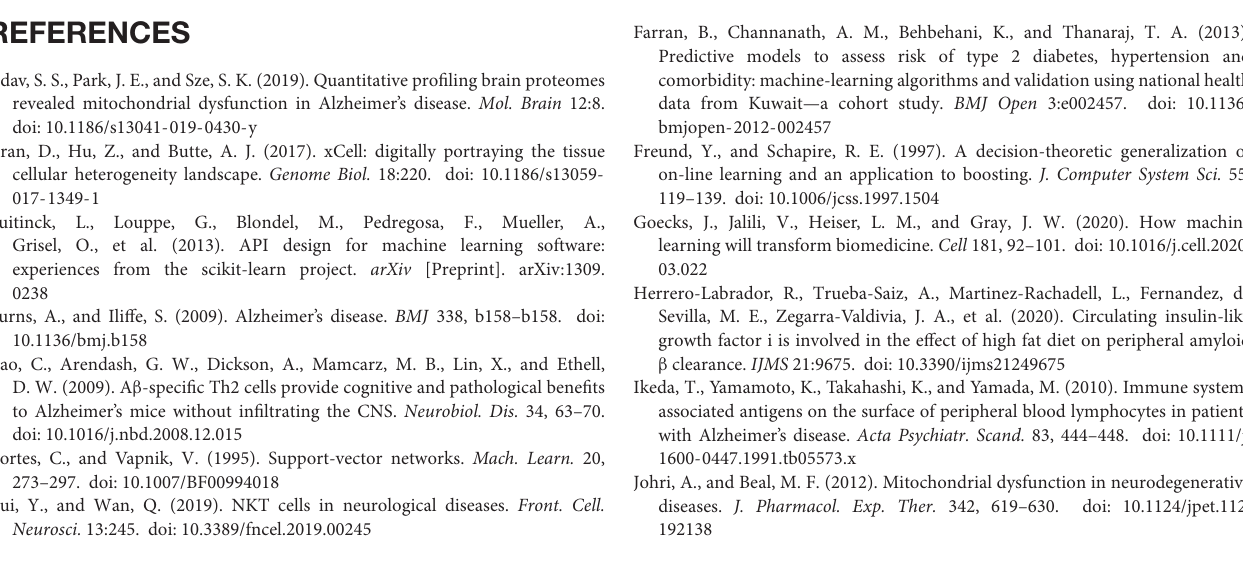
Supplementary Figure 1 | The blood mRNA expression of CON, MCI and AD patients showed a different trend. (A) Heatmap of GSE63060 and GSE63061, rows represent genes, and columns represent samples. (B) DEGs of three groups between each other, bar-plot show the number of all up-down DEGs in different groups, the Venn-plot show that the intersection DEGs, the upset-plot show that all kind of intersections DEGs. The bar graph on the left represents the intersection of up-regulated differential genes between each group. In the middle of the scatter plot, the single point represents the unique gene in the data set, and the point-line-connection represents the intersection of the data and other data. (C) IPA localization and types score of DEGs, base-line (gray-line) CON/CON, red represent cell membrane localization. (D) Pathway enrichment results, the absolute value of x-axis is log10( P -value), the positive and negative signs represent up and